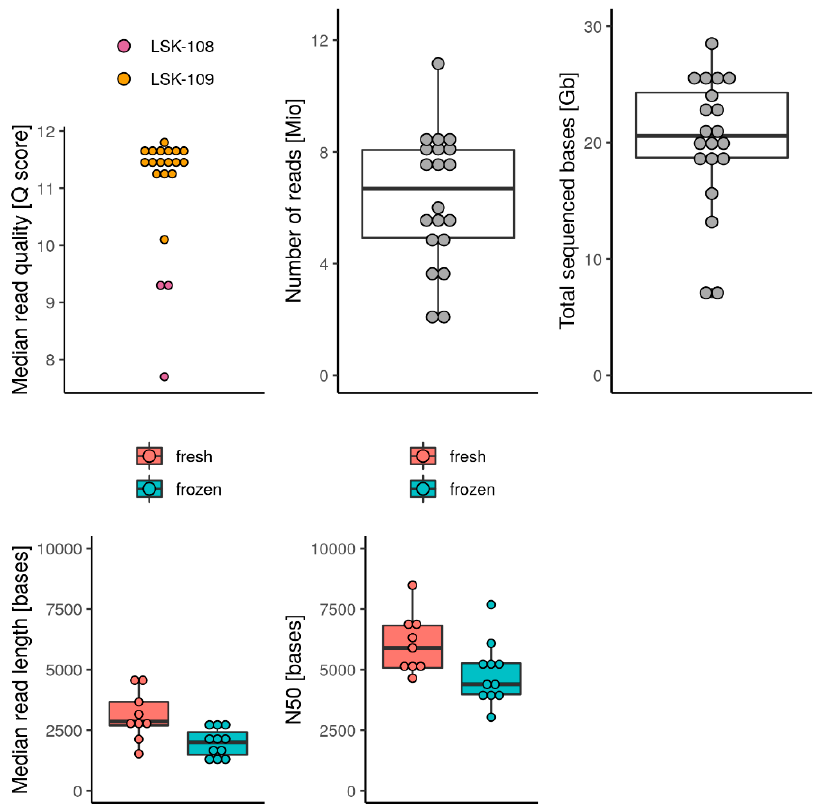
Figure 2. Summary of all 20 sequence runs of biogas reactor samples using the MinION device. Di ff erent colours indicate properties that influenced quality parameters.